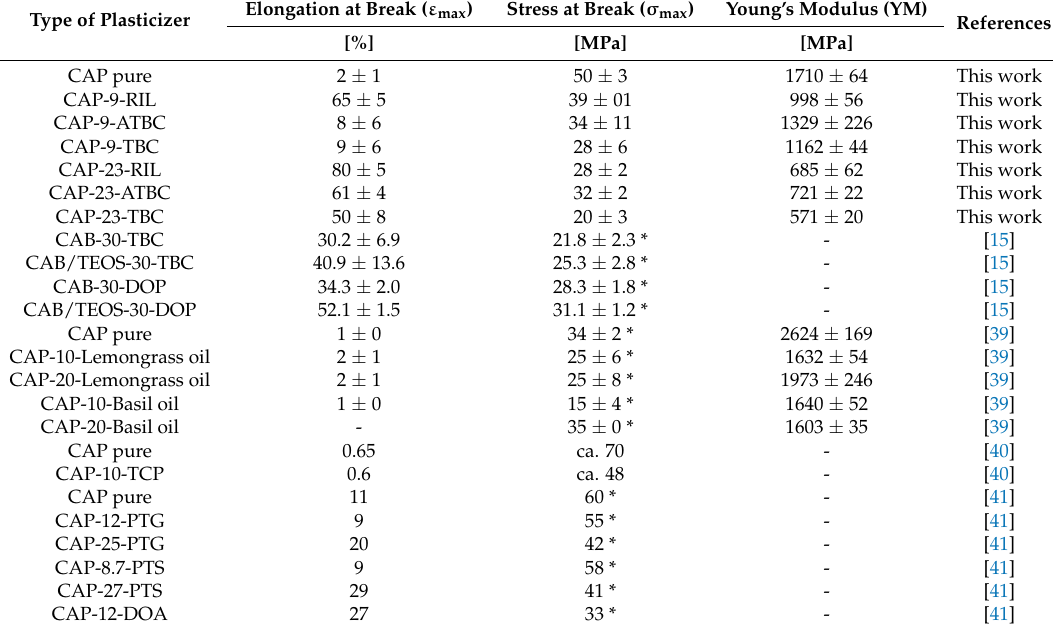
Table 2. Comparison of mechanical performance of CAP-RIL as well as plasticized CAP-TBC and CAP-ATBC membranes with published results for other cellulose ester-based